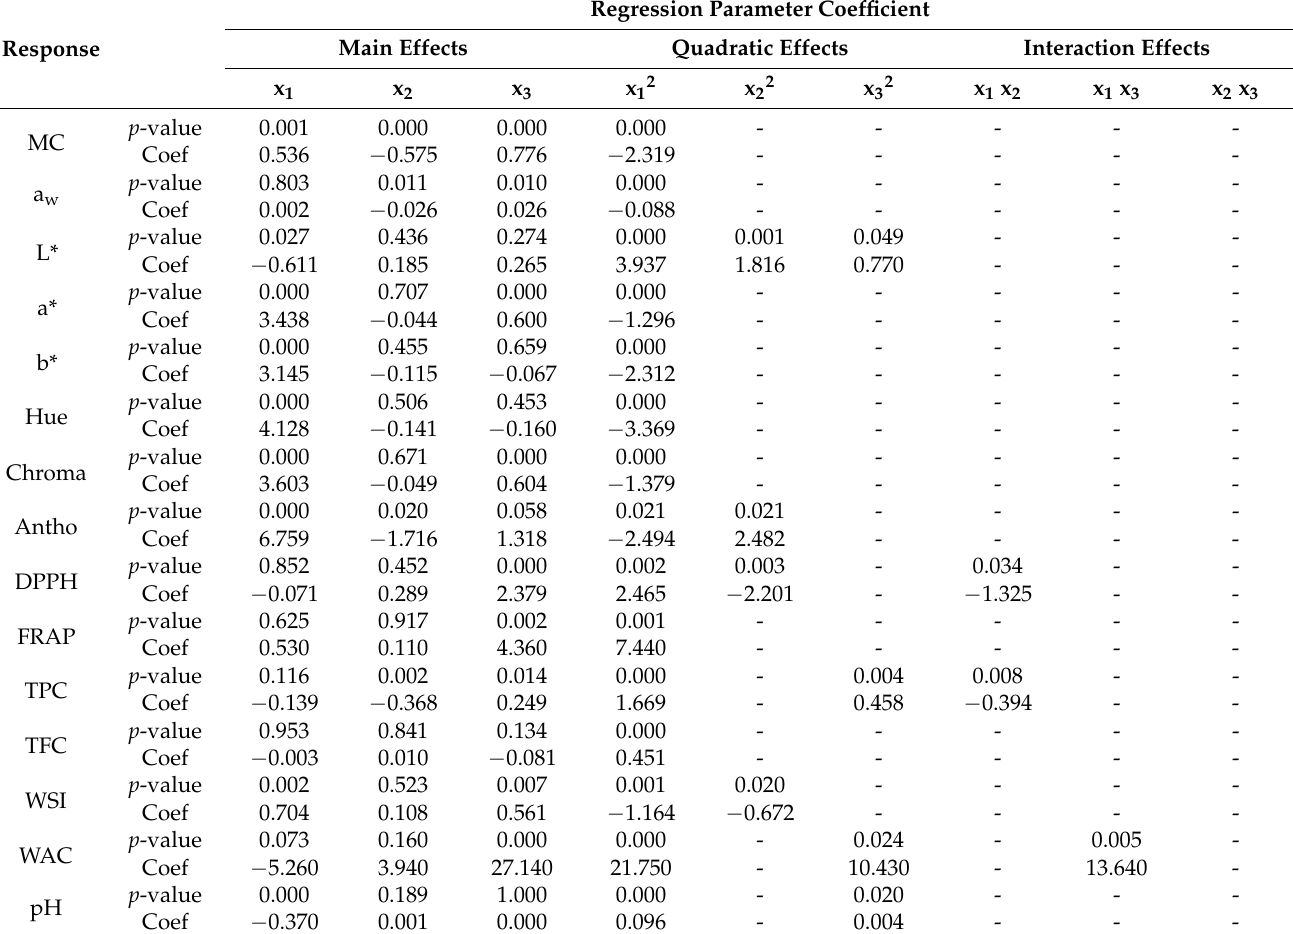
Table 4. The p -value and regression coefficient of the main, quadratic and interaction effect of different variables in the final reduced models fitted for purple sweet potato